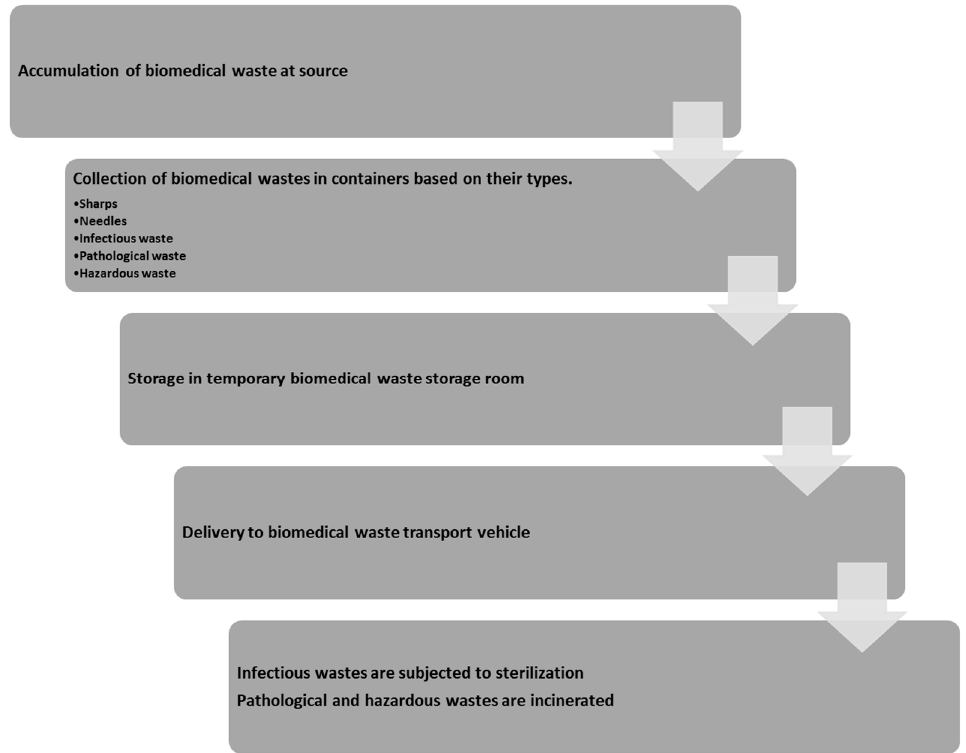
Figure 2. The biomedical waste management system, displaying the relevant steps .